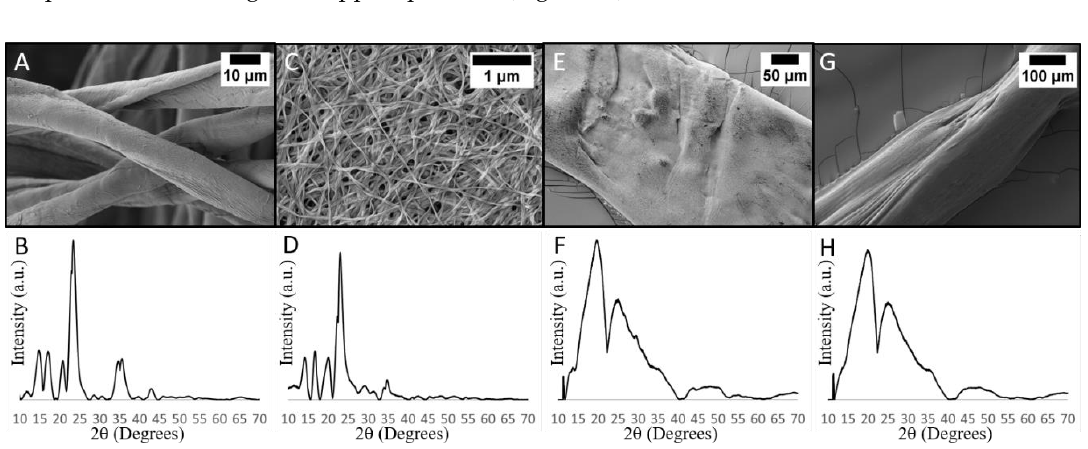
Figure 1. CuO deposition process performed on plain cotton, dried BC, and regenerated cellulose fibers: SEM images (top) and XRD spectra (bottom) are shown for plain cotton ( A , B ), dried BC ( C , D ), regenerated cotton ( E , F ), and regenerated never-dried BC ( G , H ).